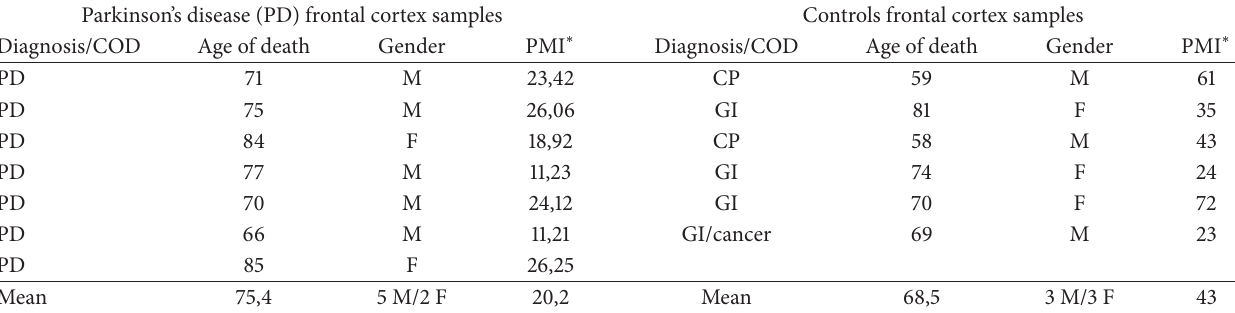
Table 1: Overview of postmortem brain tissue samples used in binding assay analysis showing sample number, diagnosis/cause of death (COD) (PD patients or controls dead of other nonneurological causes), age at time of death (age (death)), gender, and PMI (postmortem interval). CP = cardiopulmonary and GI =